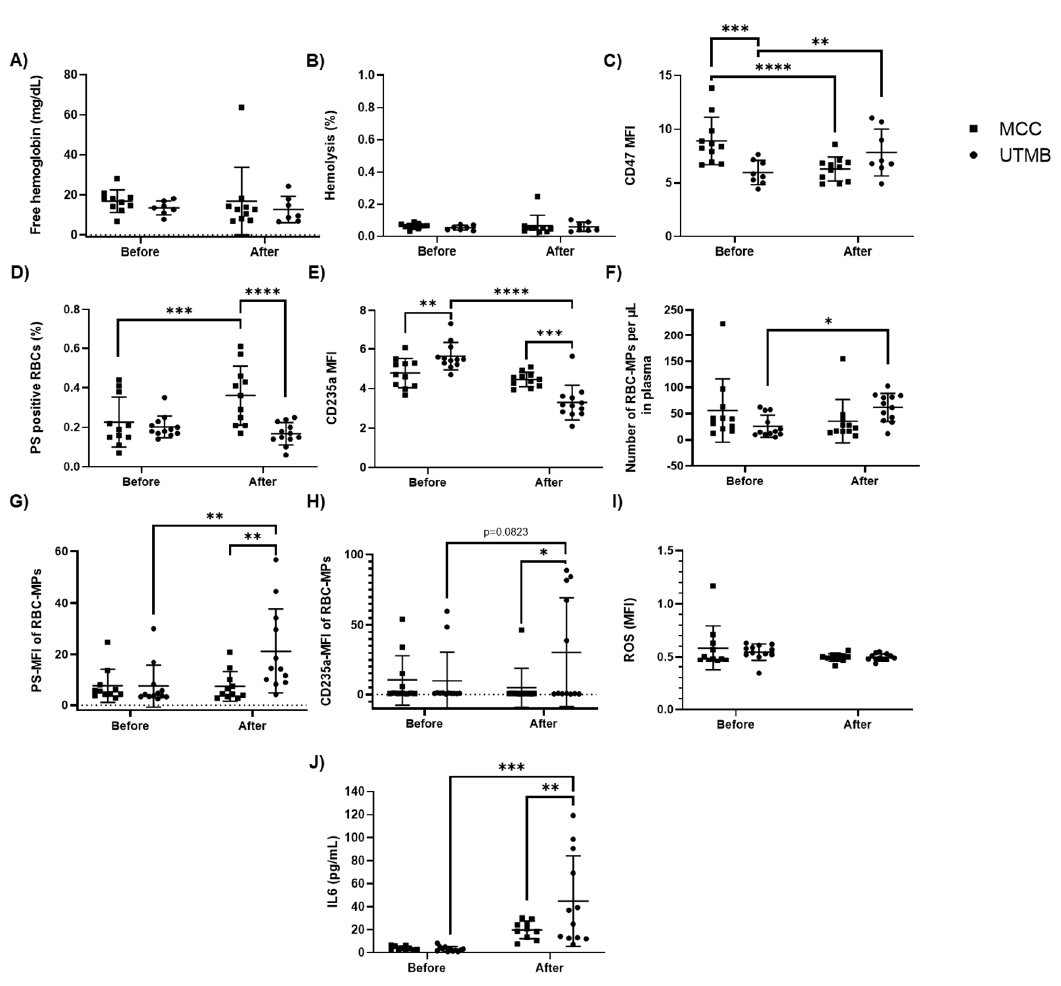
Figure 2. Evolution of markers of RBC damage and senescence and IL6 levels before and after UTMB or MCC race. ( A ) Plasma free hemoglobin (UTMB, n = 7; MCC, n = 10); ( B ) Percentage of hemolysis (UTMB, n = 7; MCC, n = 10); ( C ) Mean fluorescence intensity (MFI) of CD47 expressed at RBC surface (UTMB, n = 8; MCC, n = 11); ( D ) Percentage of RBC exposing phosphatidylserine (PS); ( E ) MFI of CD235a expressed at RBC surface; ( F ) Number of RBC-microparticles (MPs) per µL in plasma; ( G ) Mean fluorescence intensity of PS expressed in RBC-MPs; ( H ) MFI of CD235a expressed in RBC-MPs;